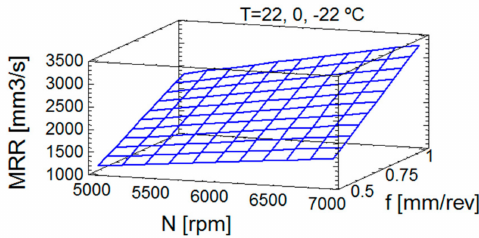
Figure 6. Estimation of response surface for MRR, at 22 ◦ C, 0 ◦ C and − 22 ◦ C.